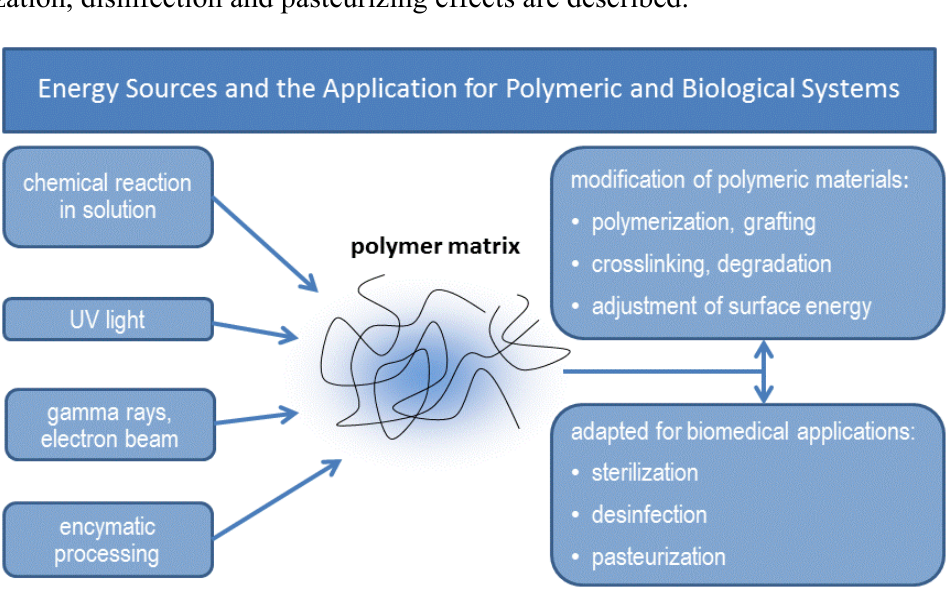
Figure 5. Energy sources and their application for polymeric and biological systems.